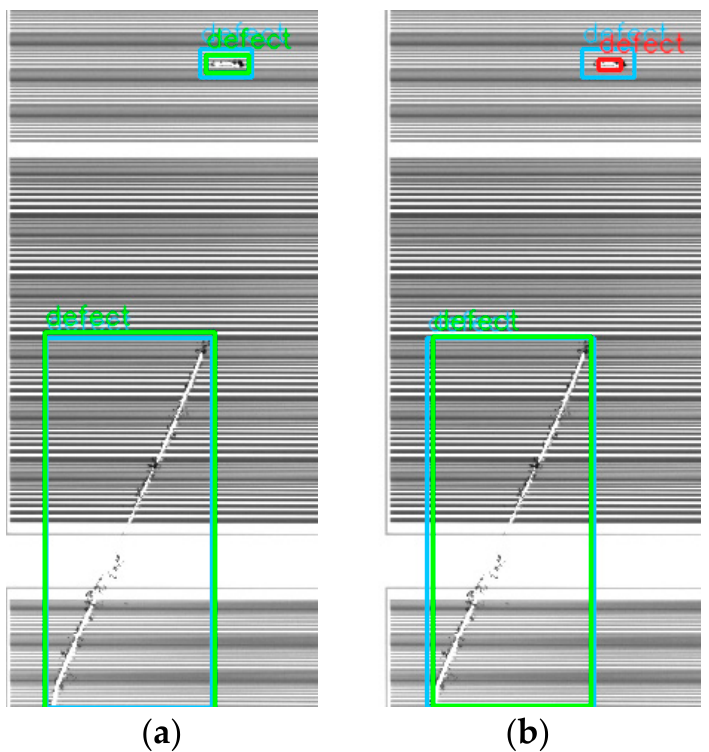
Figure 21. The detected defects in an image by using ( a ) the proposed method and ( b ) the deep learning method. The blue bounding box represents the ground truth; the gree one represents the bounding box predicted correctly, and the red one represents the bounding box predicted incorrectly.